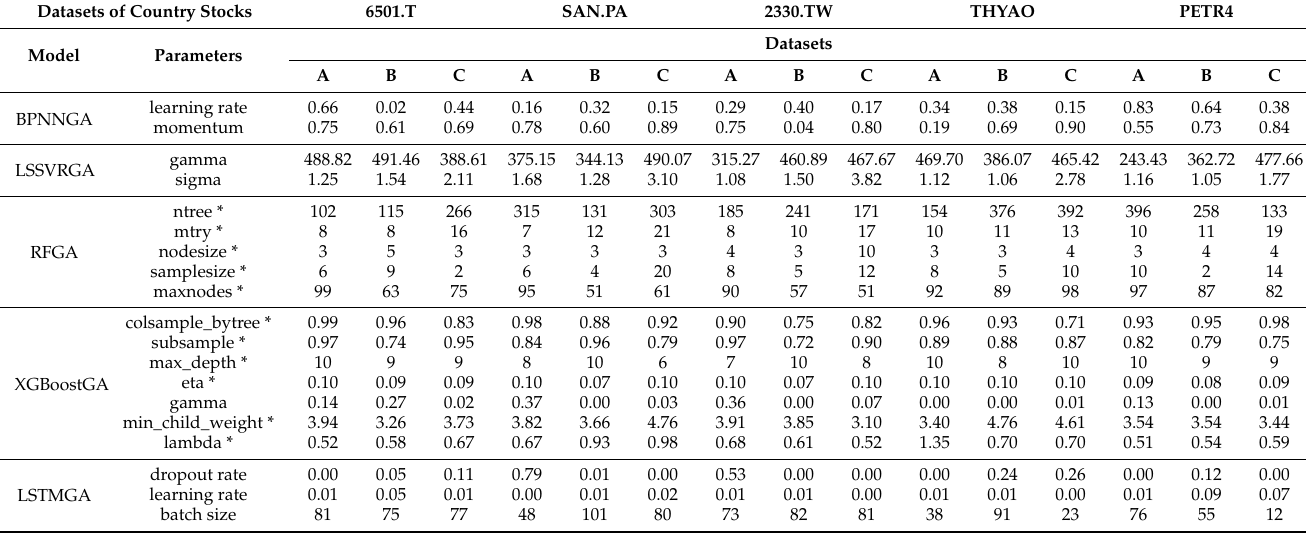
Table 8. Parameters of forecasting models for datasets A, B, and C of corporations’ stock prices. Datasets of Country